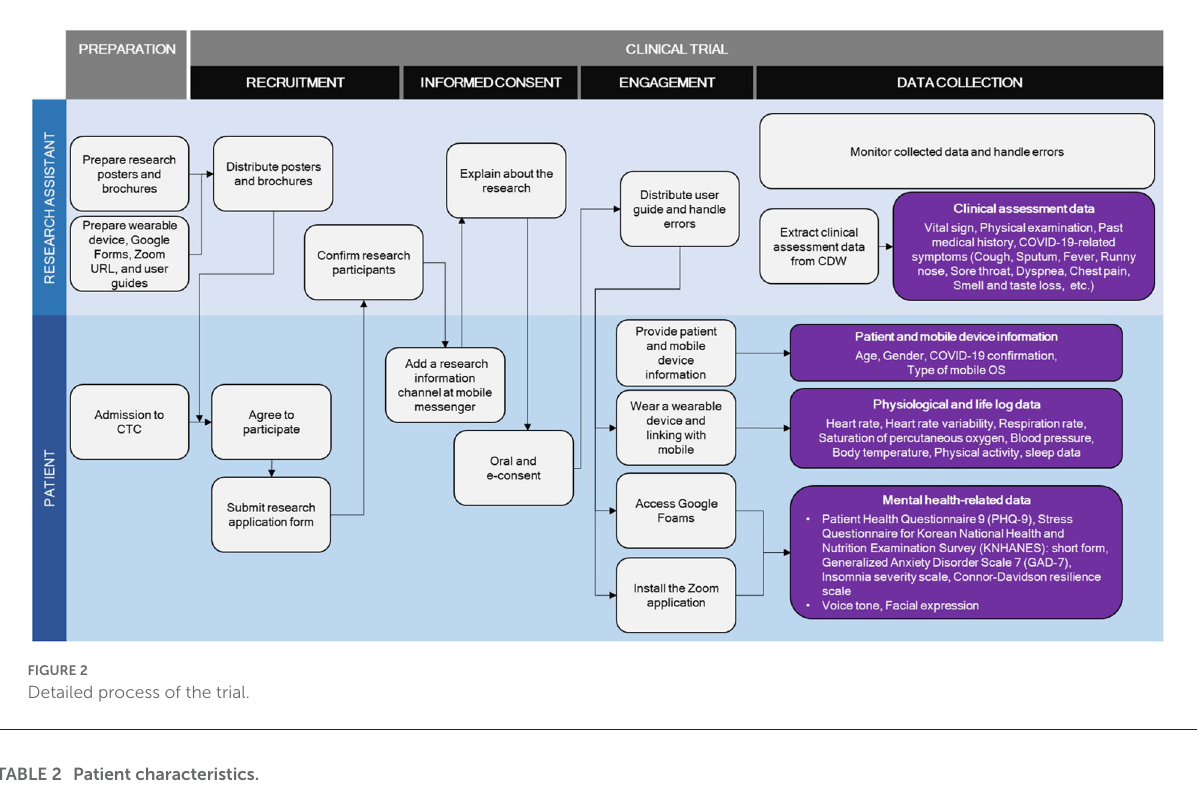
TABLE 2 Patient